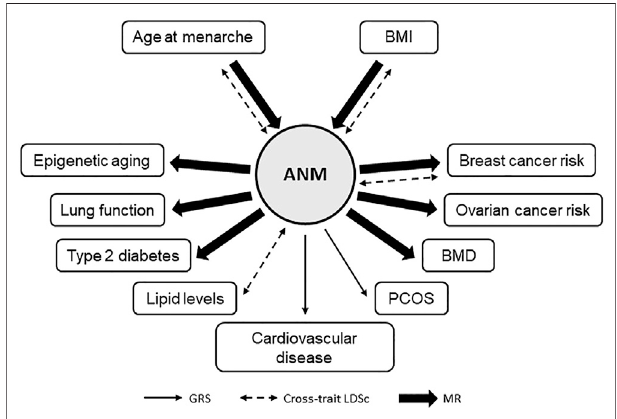
FIGURE 3 | Mendelian randomization studies for age at natural menopause.SchematicsummaryofMRstudiesforageatnaturalmenopause (ANM) with other health-related traits using ANM SNPs as instrument variables. Only traits with a signi fi cant result are